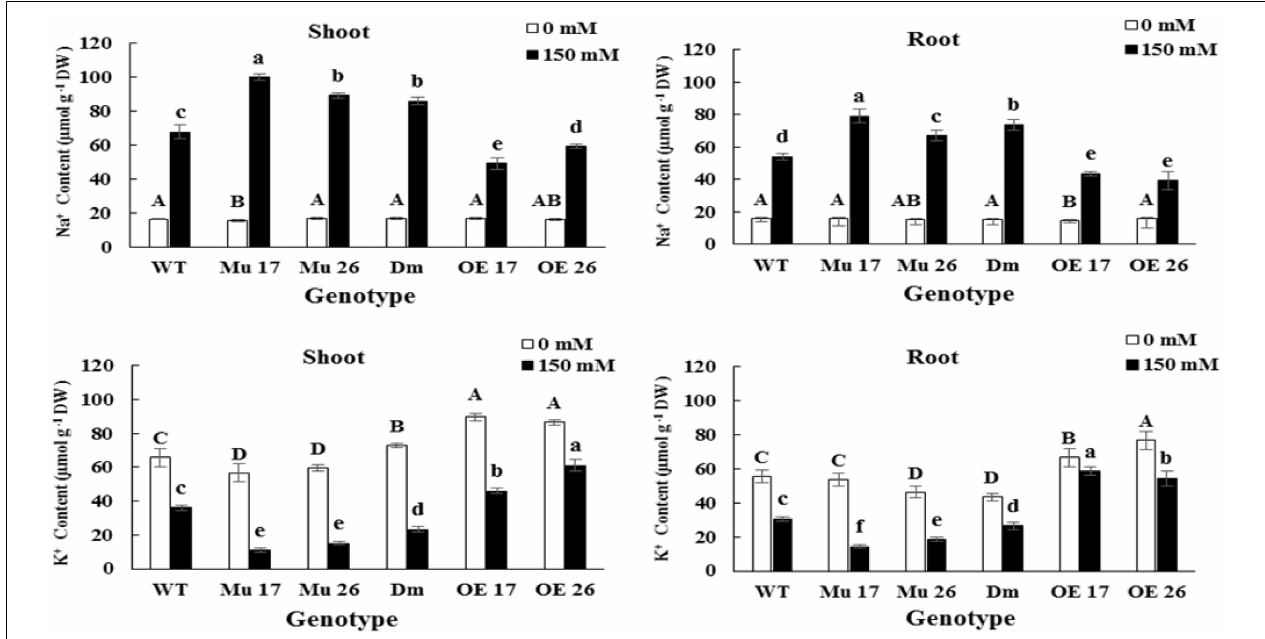
FIGURE 2 | The Na + and K + accumulation in shoots and roots of genotypes subjected to 150 mM NaCl stress compared to no NaCl stress. Wild-type (WT), overexpress (OE), single mutant (Mu), and double mutant (DM) genotypes of Arabidopsis thaliana purple acid phosphatase 17 ( AtPAP17 ) and 26 ( AtPAP26 ) genes. The significant mean differences ( P < 0.05) were separately shown at 0 and 150 mM NaCl concentrations with different uppercase and lowercase letters, respectively.